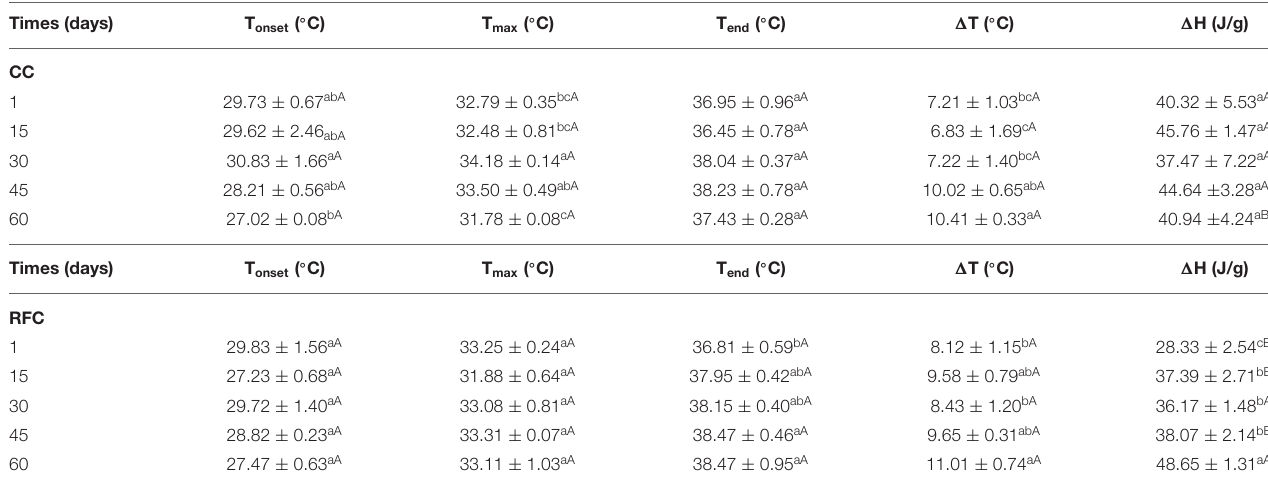
TABLE 5 | Overview of the melting profile of control chocolate (CC) and modified chocolate (RFC). Times